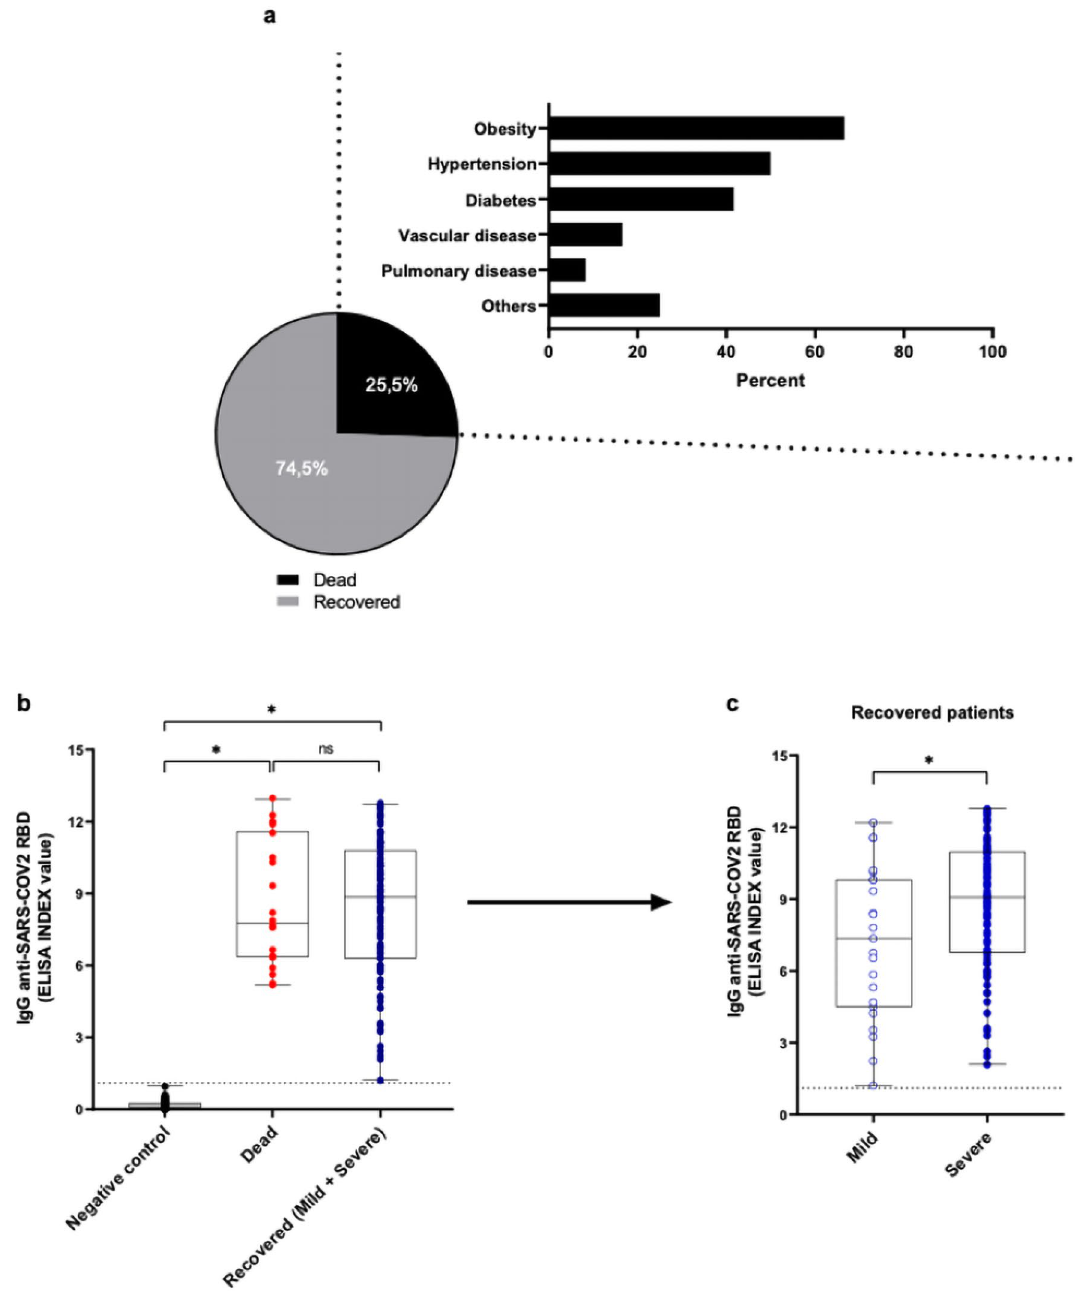
Figure 2. IgG antibody levels to SARS-CoV-2 RBD in patients who recovered (mild or severe) or who died with COVID-19. ( a ) Percentage of patients who recovered or died of COVID-19 and main comorbidities disease-associated. A detailed description of other comorbidities was shown in Table 1. ( b ) Levels of antibodies to SARS-CoV-2 RBD in patients who recovered (blue) or died (red) of COVID-19 or negative controls (black) were expressed as EI. ( c ) Paired analysis of RBD-specific IgG levels in survived patients displayed mild and severe clinical presentation of COVD-19. Aligned dot plots and boxplots show EI values (dots), medians (middle line), third and first quartiles (boxes), while the whiskers display the minimum and maximum values. The dashed lines indicate the cut-off values. Statistically significant differences were determined by Kruskal–Wallis and Dunn’s multiple comparisons test or Mann–Whitney test when appropriate (* P < 0.05). Not significant